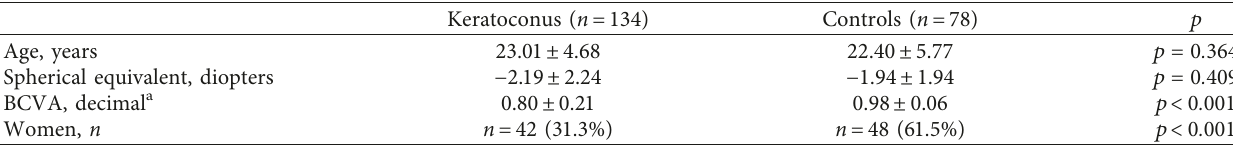
Table 1: Summary of demographical and clinical characteristics by group.